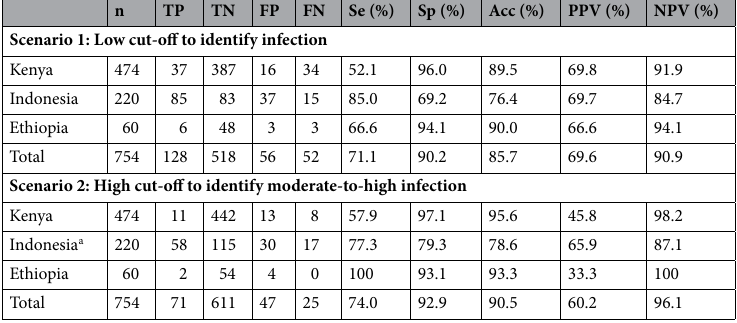
Table 2. Diagnostic parameters of urinary 2-MPC as marker for A. lumbricoides . a M&HI infection in